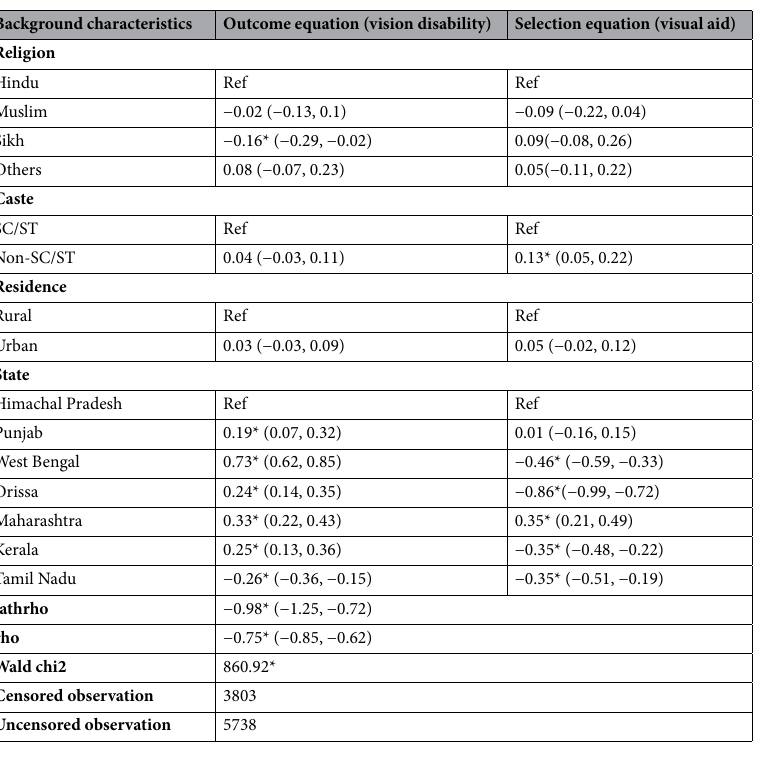
Table 3. Heckprobit model for vision disability and using visual aids among older adults in India. Ref: reference, SC/ST: scheduled caste/scheduled tribe. *If p <